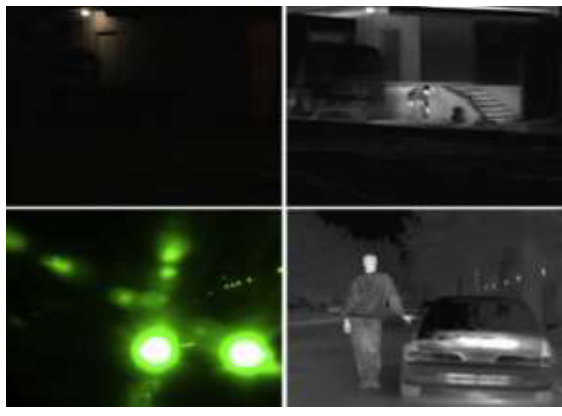
Figure 1. Visible images (left column) and thermal images (right column) of the same scenes that pedestrians are detected in thermal images with insufficient or over illumination [4].